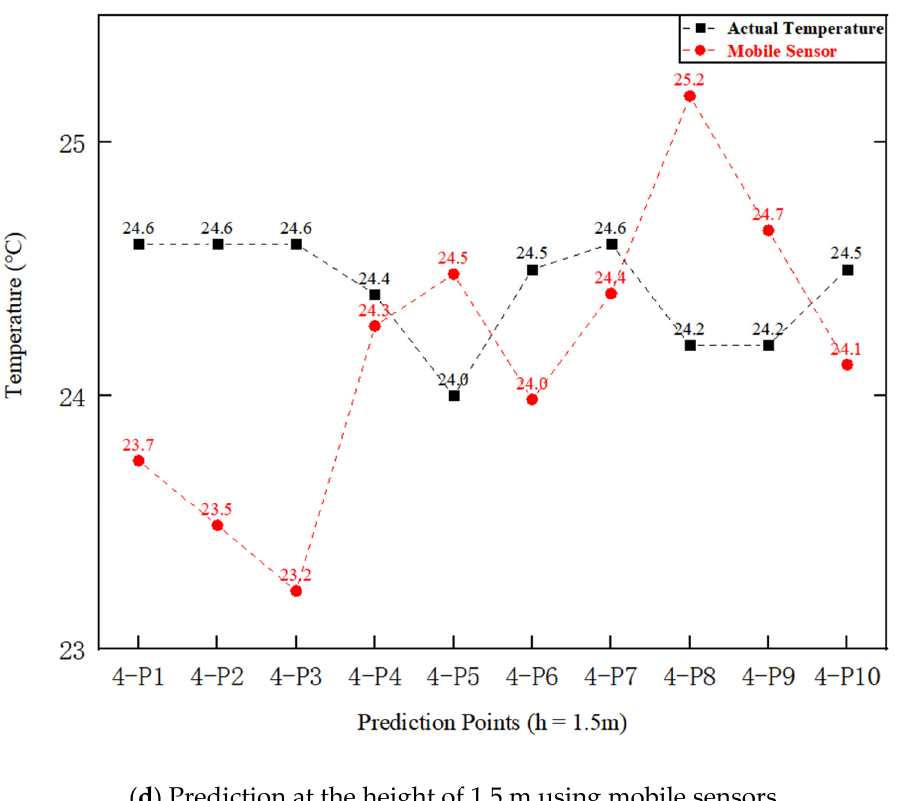
Figure 10. Prediction of different heights using mobile sensors.